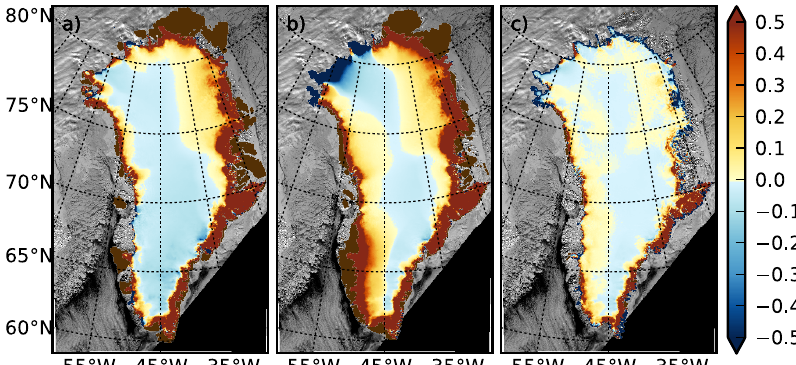
Fig. 2. Relative difference in ice thickness (model-observation)/observation. (a) “constant-climate” hindcast. (b) “paleo-climate” hindcast. (c) “flux-corrected” paleo-climate hindcast (only shown for comparison, as ice thickness was part of the initialization). Blue and red colors indicate the model under- and overestimates ice thickness, respectively. Brown color indicates areas where observed ice thickness is zero but the model simulates an ice thickness in excess of 100m.